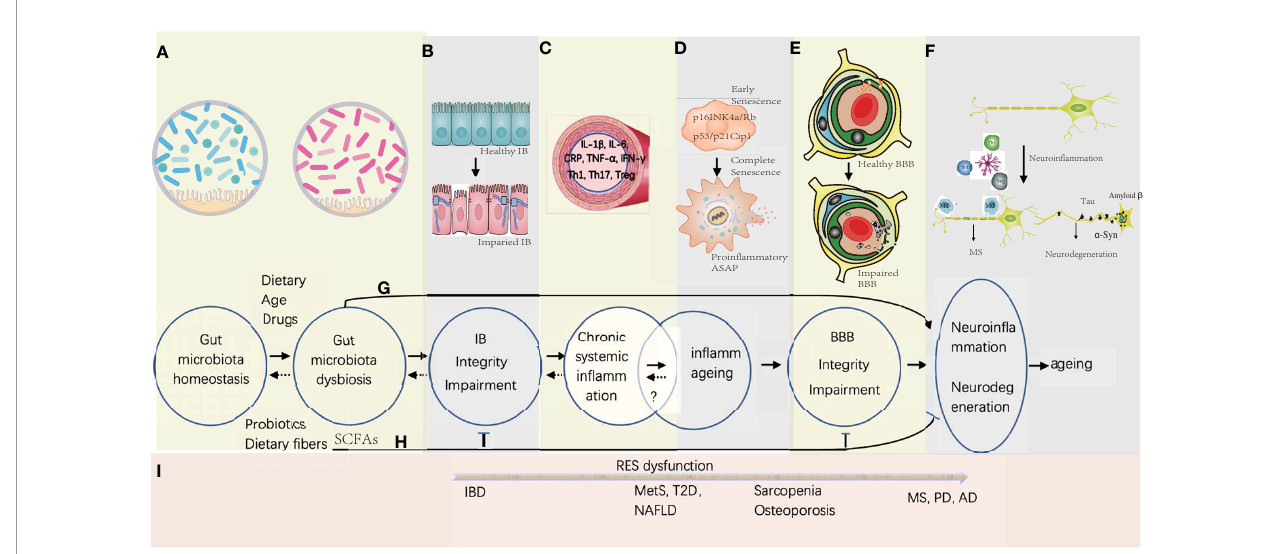
FIGURE 1 | Gut microbiota-associated processes of neuroin fl ammation and neurodegeneration in aging. (A) Gut microbiota homeostasis could be disturbed by Western diet, drugs, and increasing age, while the probiotics and dietary fi ber is bene fi cial in maintaining the homeostasis. (B) Gut microbiota dysbiosis would induce the gut epithelial in fl ammation together with the TJ disintegration and the apoptosis of the gut epithelial cells. (C) Proin fl ammation factors and primed immune cells from the gut tract would translocate into systemic circulation, which might be reversible by promptly correcting the gut microbiota homeostasis. (D) Senescence of somatic cells could be induced by unresolved chronic systemic in fl ammation with activation of signaling pathways of p16INK4a/Rb and p53/p21Cip1 at early stage, and progressed into full senescent stage by secreting proin fl ammatory ASAP. Whether the stage of the in fl ammaging is reversible is under investigation. (E) Sustained systemic in fl ammation would cause the remodeling of the BBB architecture with increasing permeability and collapse. (F) In fl ux of the immune cells and proin fl ammatory factors would activate the microglia in the brain, and further stimulate neuroin fl ammation and neurodegeneration. (G) Before the de fi ciency of IB and BBB, some small molecules derived from the metabolites of the pathogenic gut symbiotics would be transported into the brain and induce CNS in fl ammation. (H) SCFAs produced by probiotics have the potential to enhance the integrity of IB and BBB, and decreases the risk of neuroin fl ammation and neurodegeneration. (I) In general, with the dysfunction of the reticular endothelial system (RES), local gut in fl ammation induced by microbial dysbiosis would spread to other organs gradually to cause different diseases from IBD of gut to MS, PD, and AD in the